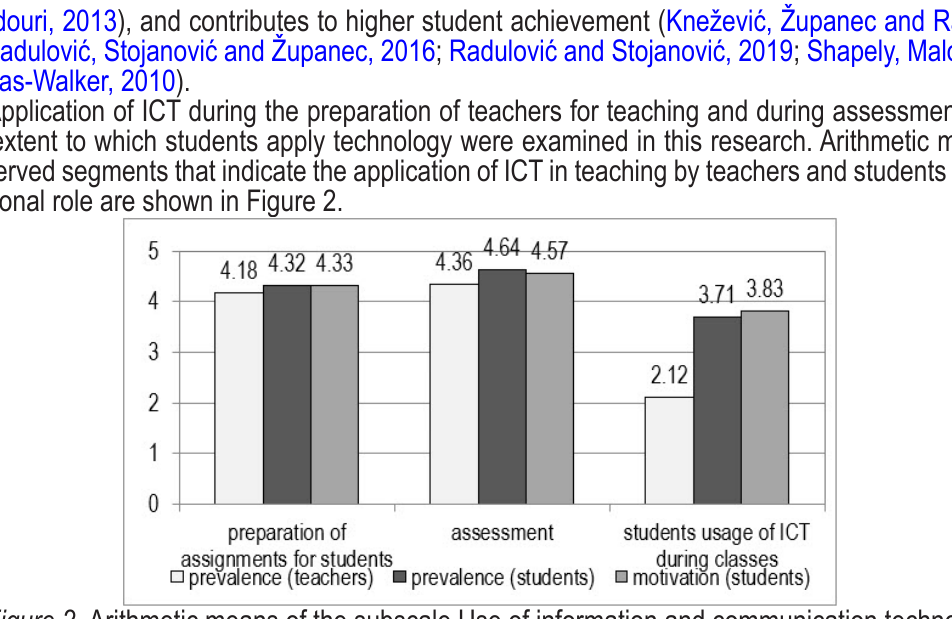
Figure 2. Arithmetic means of the subscale Use of information and communication